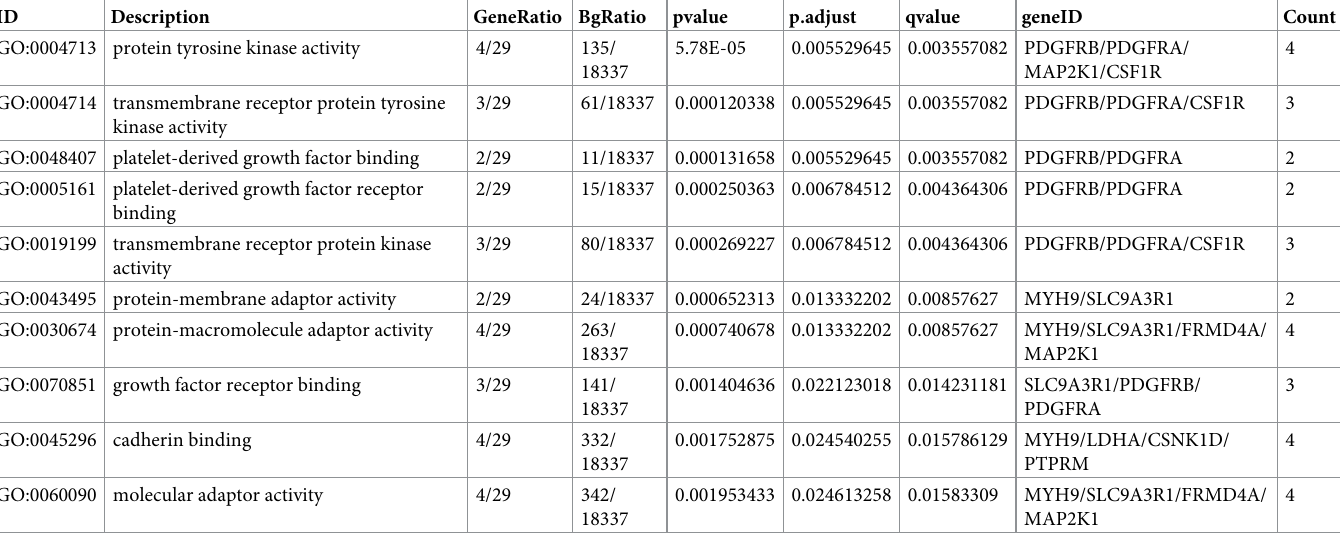
Table 1. GO enrichment analysis.